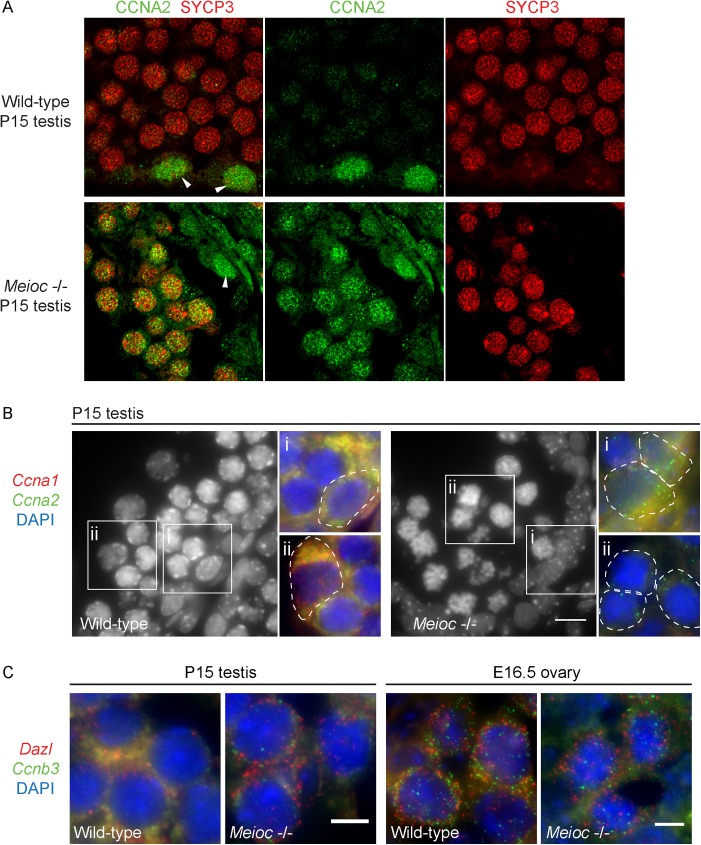
Expression of cyclin A2 and cyclin B3 in Meioc-deficient adult testis and ovary.(A) Immunofluorescence staining for CCNA2 and SYCP3 in wild-type and Meioc -/- P15 testis. In wild-type, CCNA2 is expressed in mitotic spermatogonia (arrowhead), and is not expressed in cells past the leptotene stage of meiosis (SYCP3+ cells at zygotene stage of meiosis). In Meioc -/- testes, CCNA2 is misexpressed in SYCP3+ cells at zygotene-like stage. (B) Single molecule FISH staining for Ccna1 and Ccna2 in wild-type and Meioc -/- P15 testis. Low magnification image: DAPI staining of germ cells in testis tubule. High magnification images: DAPI is in blue, and single cells are outlined. Single transcripts are detected as individual red or green dots; diffuse staining is background. Ccna2 (green dots) is detected in both wild-type and Meioc -/- testes in mitotic spermatogonia, identified by their position at base of tubule and by their nuclear morphology (wild-type and Meioc -/-, i). Ccna2 is additionally detected in Meioc -/- germ cells that are in middle of lumen (likely meiotic, or else metaphasic cells, ii). Ccna1 (red dots) is detected in late pachytene germ cells in wild-type testis, but not in Meioc -/- germ cells (wild-type and Meioc -/-, ii). (C) Single molecule FISH staining for Ccnb3 and Dazl in late zygotene/early pachytene germ cells from wild-type and Meioc -/- P15 testis and E16.5 ovary. Ccnb3 and Dazl are detected in both wild-type and Meioc -/- germ cells. Scale bar = 10 μm.